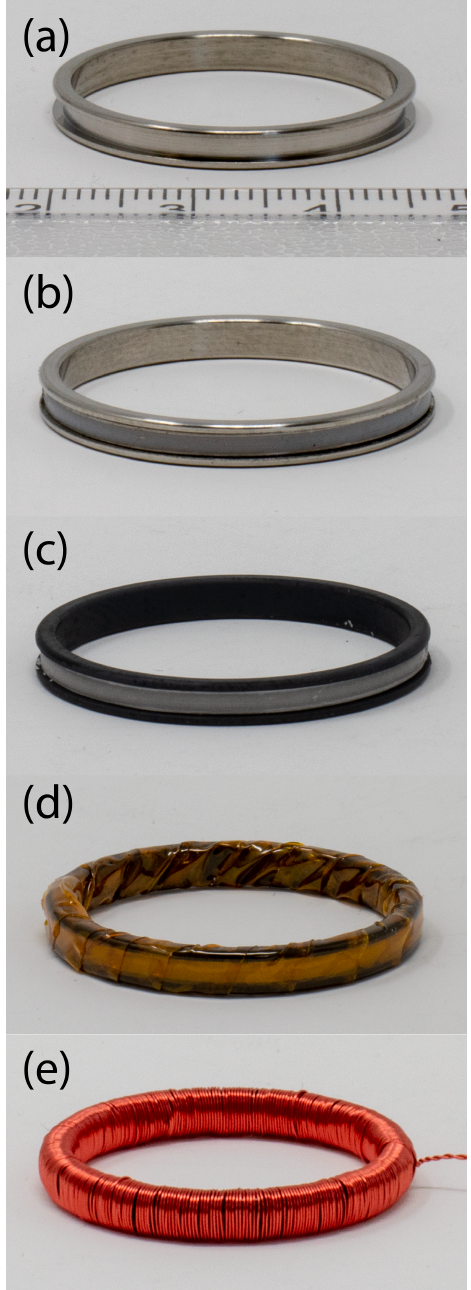
Figure 4. Major steps in the production of an S1000-compatible ring core. (a) Inconel bobbin used to form the ring core and pro- vide mechanical support. (b) Insulator-coated permalloy foil strips spiral-wound and welded to bobbin. (c) Same, but after heat treat- ment. (d) Wrapped in polyimide tape. (e) Drive winding applied.